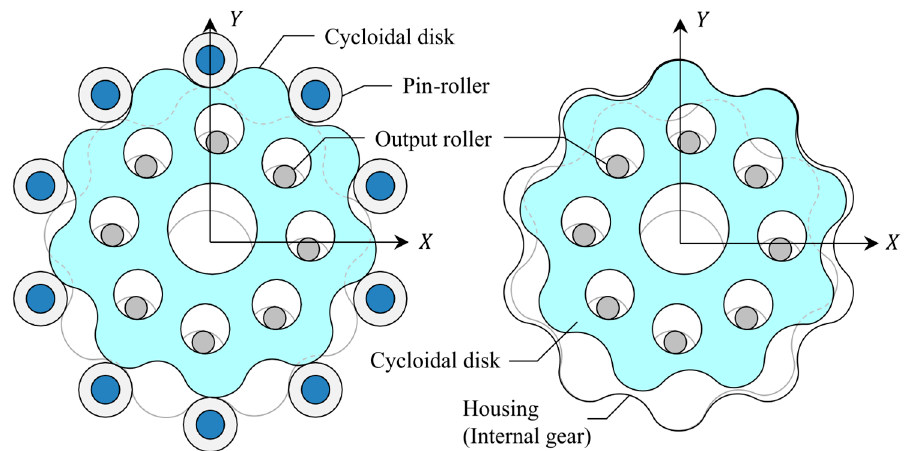
Figure 1. Comparison of cycloidal reducer ( left : Traditional method, right : proposed method). An epicycloid is a path traced by a point on the rolling circle that rotates outside the base circle. Similarly, an epitrochoid is a geometric curve traced by a fixed point inside a rolling circle that rotates around the perimeter of the base circle.